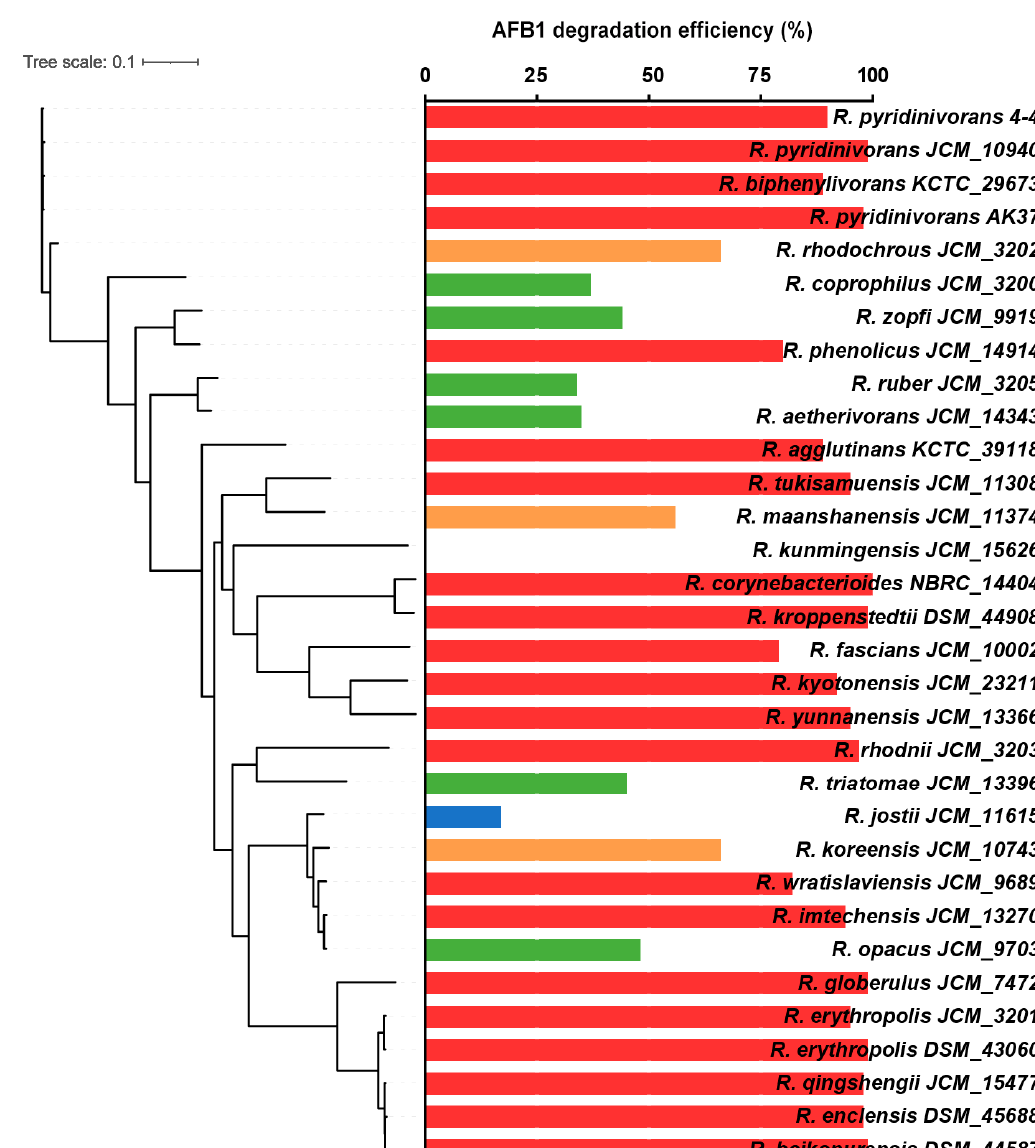
Figure 4. Maximum-likelihood phylogeny, estimated from the core gene alignments of 32 Rhodococcus strains. The AFB 1 degradation efficiencies of these strains are shown. Rows in red indicate strong degrading ability.